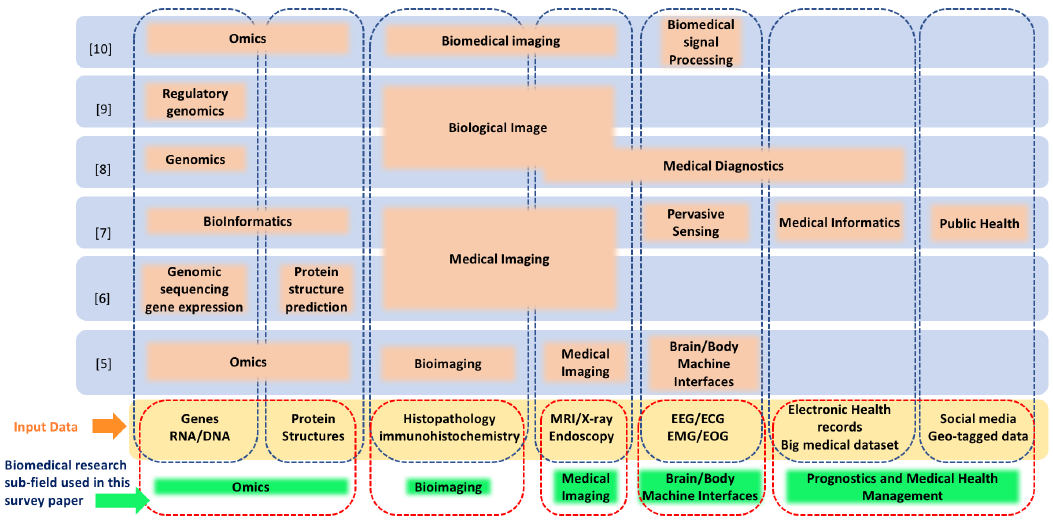
Figure 3. Different contributions and view points given by each survey paper recently published in the field of deep learning, applied to biomedical